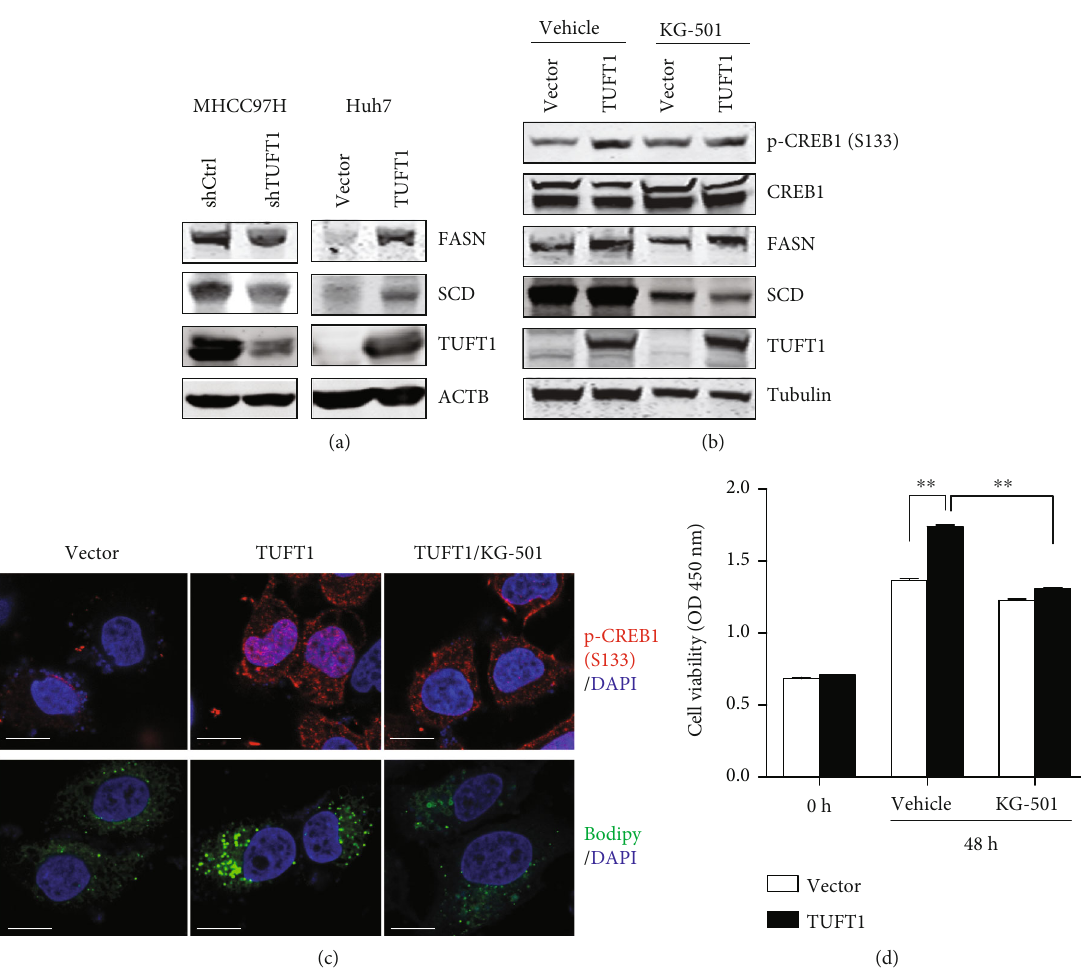
Figure 5: Inhibition of CREB1 reversed the promotion of cell proliferation by TUFT1 overexpression. (a) Western blot analysis of FASN and SCD in TUFT1-overexpressing or knockdown cells. (b) Western blot analysis of p-CREB1, FASN, and SCD in TUFT1- overexpressing Huh7 cells, treated with KG-501 or vehicle control. (c) Upper panel: immuno fl uorescence of p-CREB1 (Ser133) in vector, TUFT1 overexpression, and KG-501-treated TUFT1-overexpressing Huh7 cells; down panel: BODIPY 493/503 dye staining in these cells. Scale bar: 10 μ m. (d) Cell proliferation analysis of Huh7 cells, treated with KG-501 or vehicle control. ∗∗ P < 0 : 01